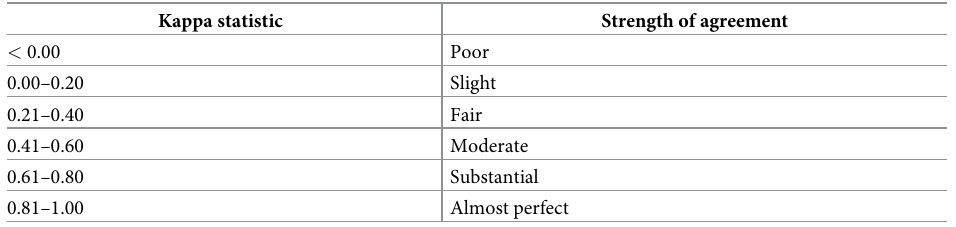
Table 2. Kappa Index Interpretation